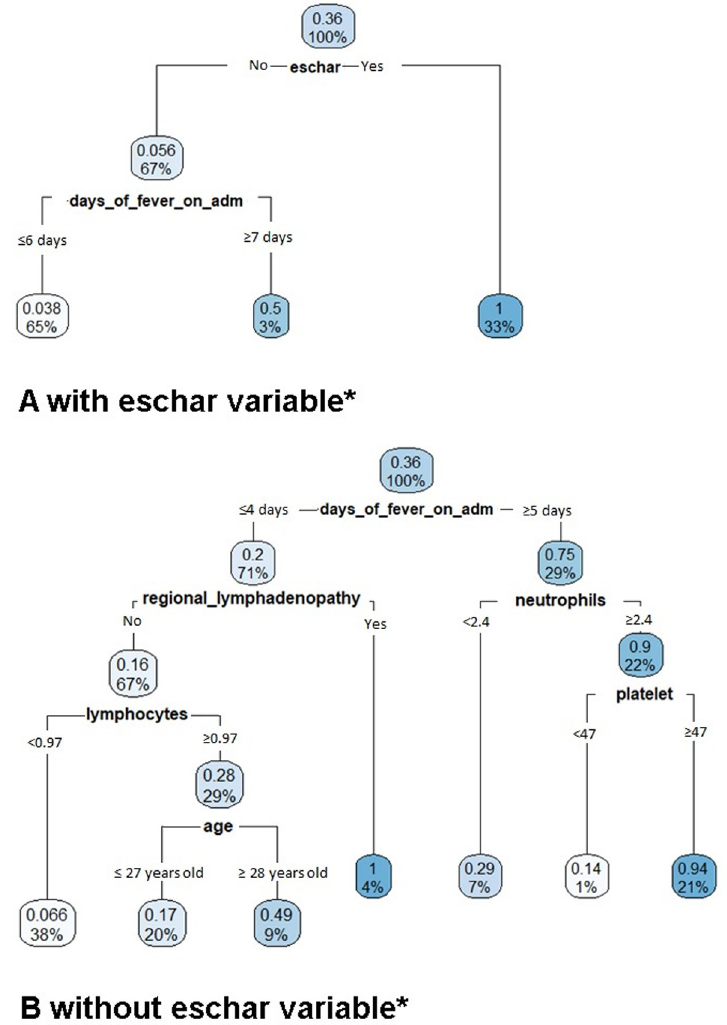
Fig 4. Regression tree for scrub typhus using the entire data set. � Panel A: tree obtained when offering the variable “eschar”; panel B: tree obtained when not offering the variable “eschar”.